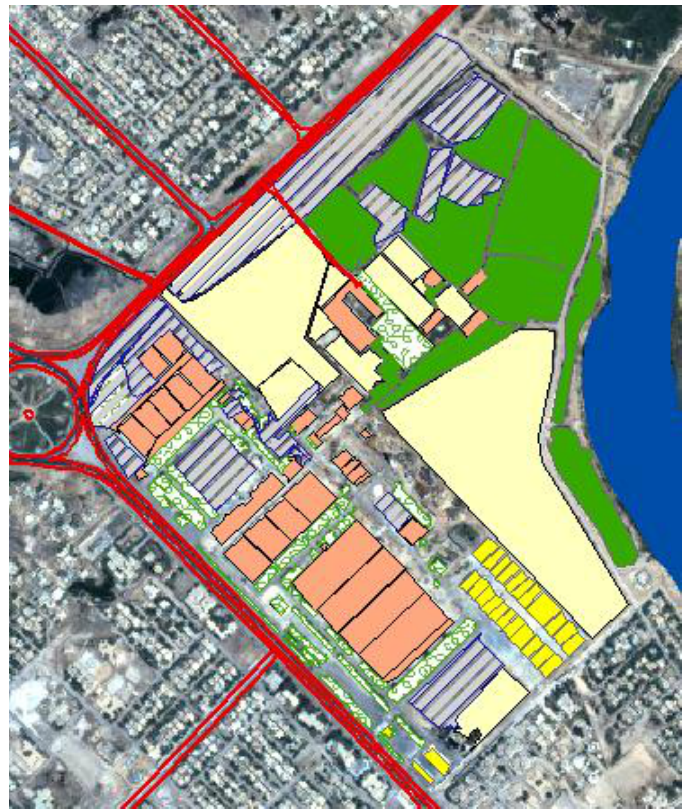
Fig.19: Presented some features containing high resolution image.